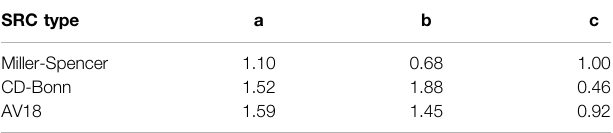
TABLE 1 | Parameters for the short-range correlation (SRC) parametrization of Eq. 21 . Values are taken from Ref. (Horoi and Stoica, 2010). SRC